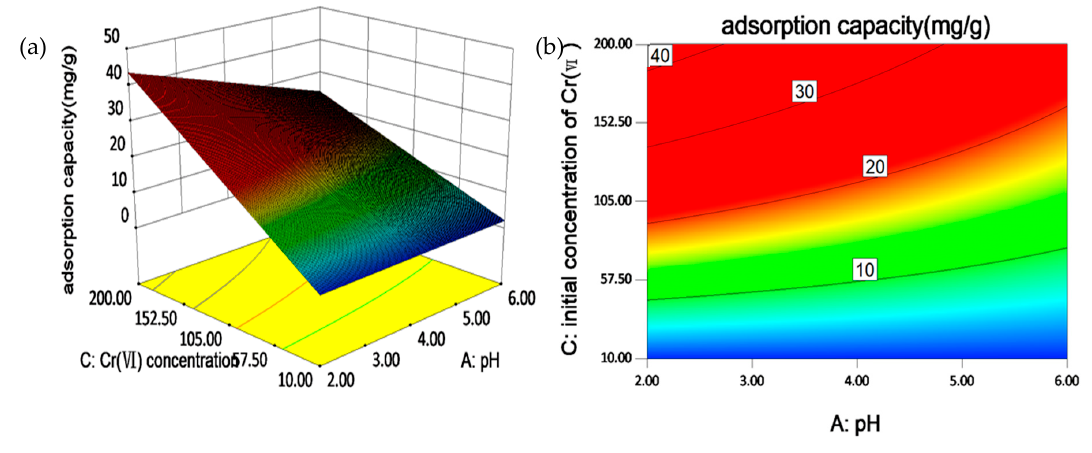
Figure 6. ( a ) Three-dimensional (3D) surface response plot and, ( b ) two-dimensional (2D) contour curves for AC (A: pH values; B: initial concentration of Cr(VI)) interactive effects on the adsorption of Cr(VI).